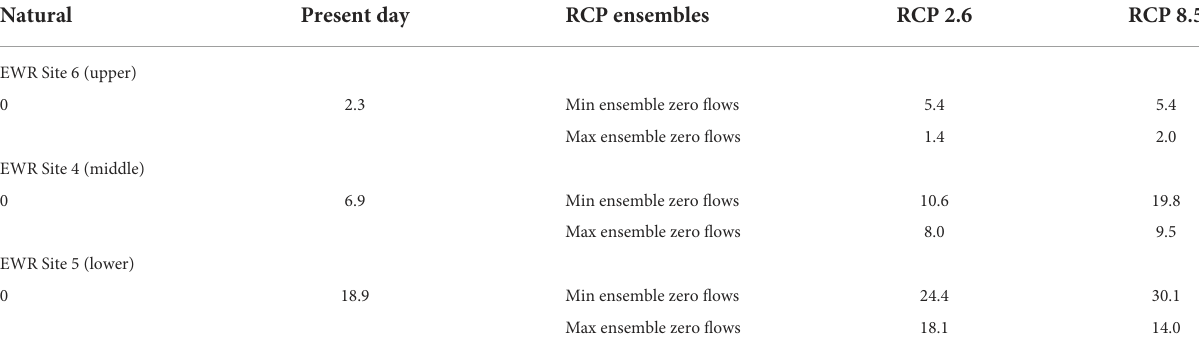
TABLE 5 Percent time zero monthly flow (%) under current climate (natural and present day hydrology; 1981–2010) vs. that for the minimum and maximum ensembles under RCP 2.6 and 8.5 (2041–2070) for the three quaternary catchments corresponding to the three Ecological Reserve sites. Natural Present day RCP